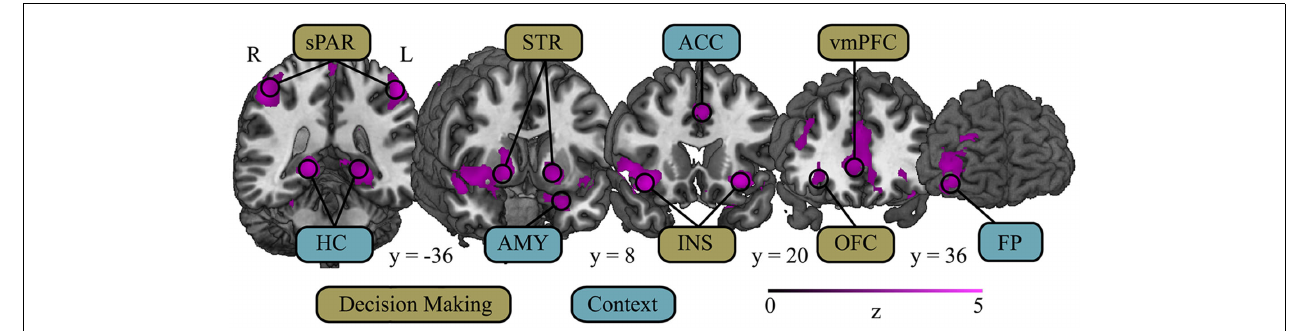
associated with memory and context showed increased activation with age during the decision period.These regions include: anterior cingulate cortex